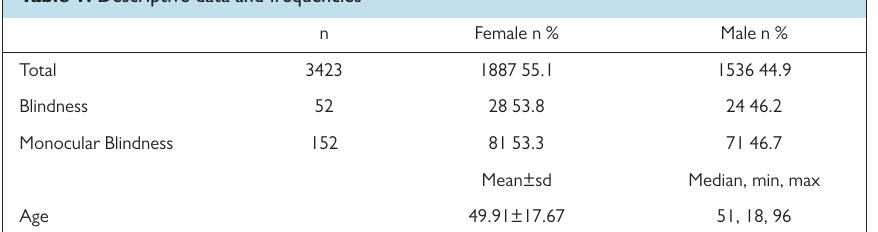
Table 1. Descriptive data and frequencies